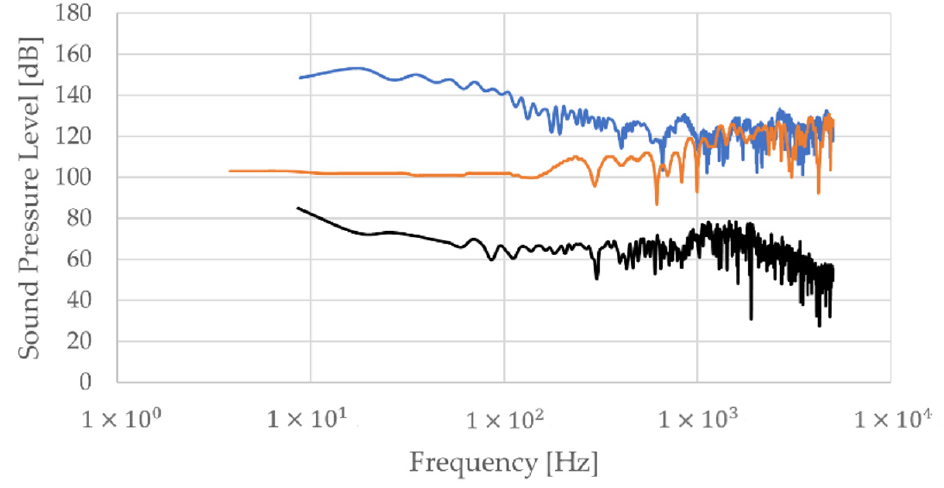
Figure 10. The contrast of sound pressure levels of all blades (3b, 4b & 5b) at hydrophone (receiver, R1 at 5d distance).